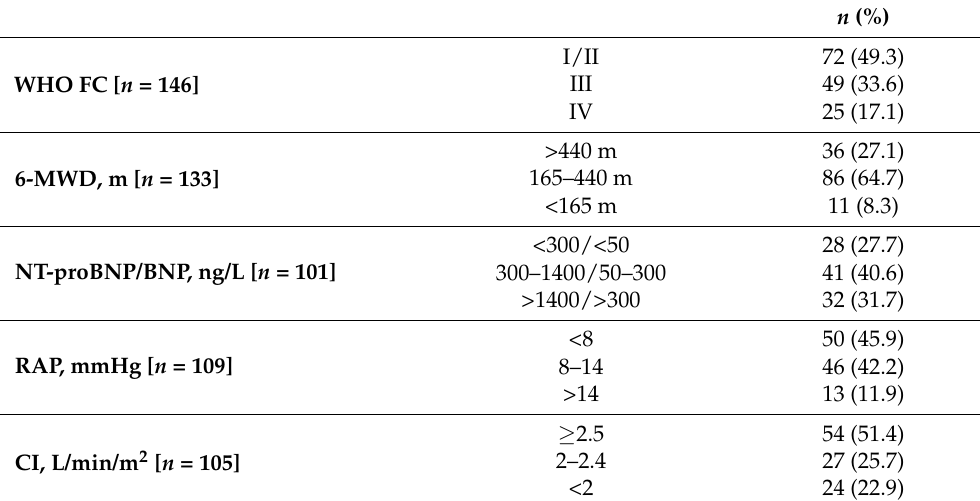
Table 2. Clinical and Hemodynamic Characteristics of the Cohort Used in Risk